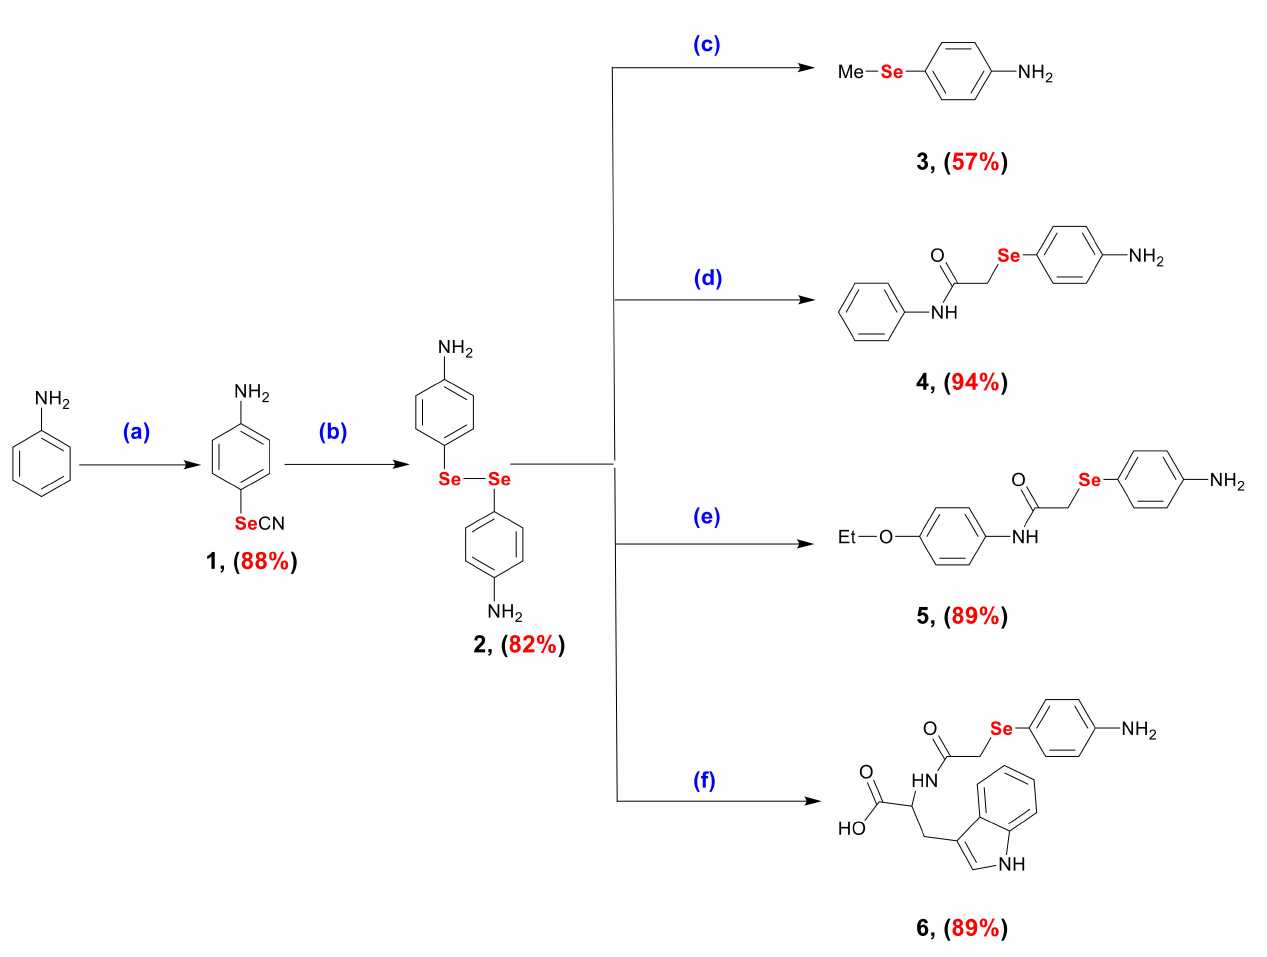
Scheme 1. Synthesis of OSe agents 3 , 4 , 5 , 6 . Reagents and conditions: ( a ) Aniline (72